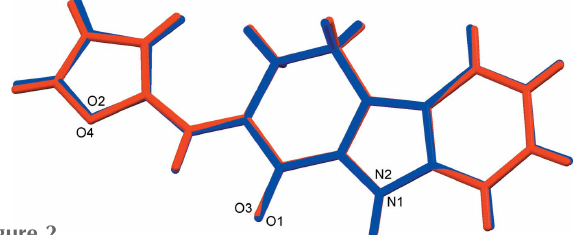
Figure 2 Molecular overlay of inverted molecule B (red) on molecule A (blue).